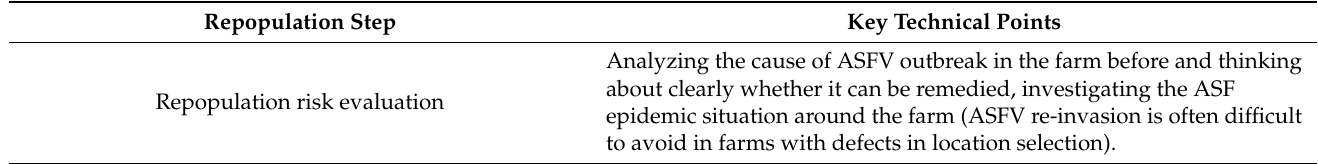
Table 5. Key technical points in six steps of pig farm